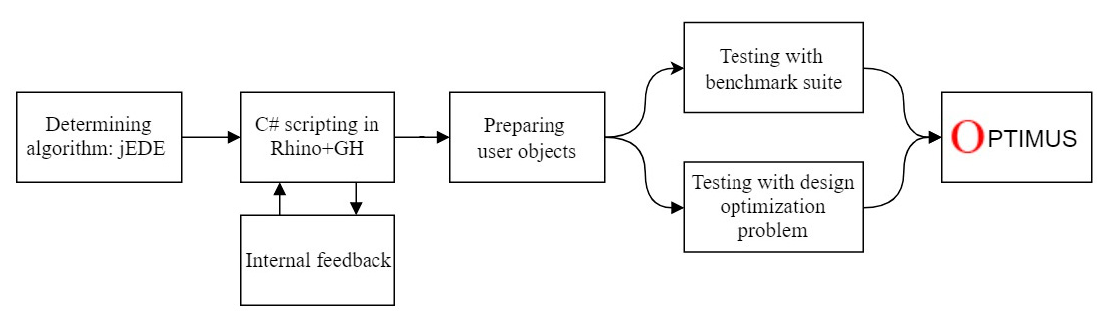
Figure 3. Optimus development process.